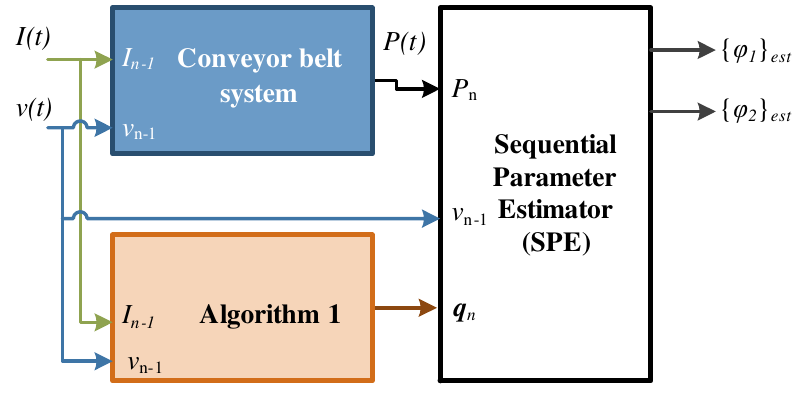
Figure 11. Parameter identification